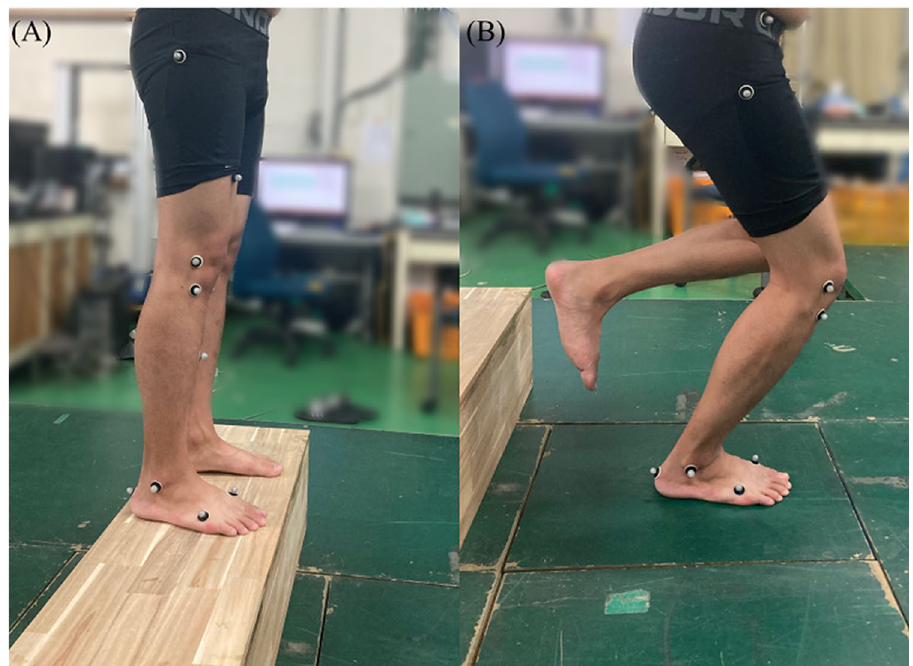
Figure 4. Experimental setup for drop single-leg landing test. ( A ) initial position of drop landing and ( B ) Final position of single-leg